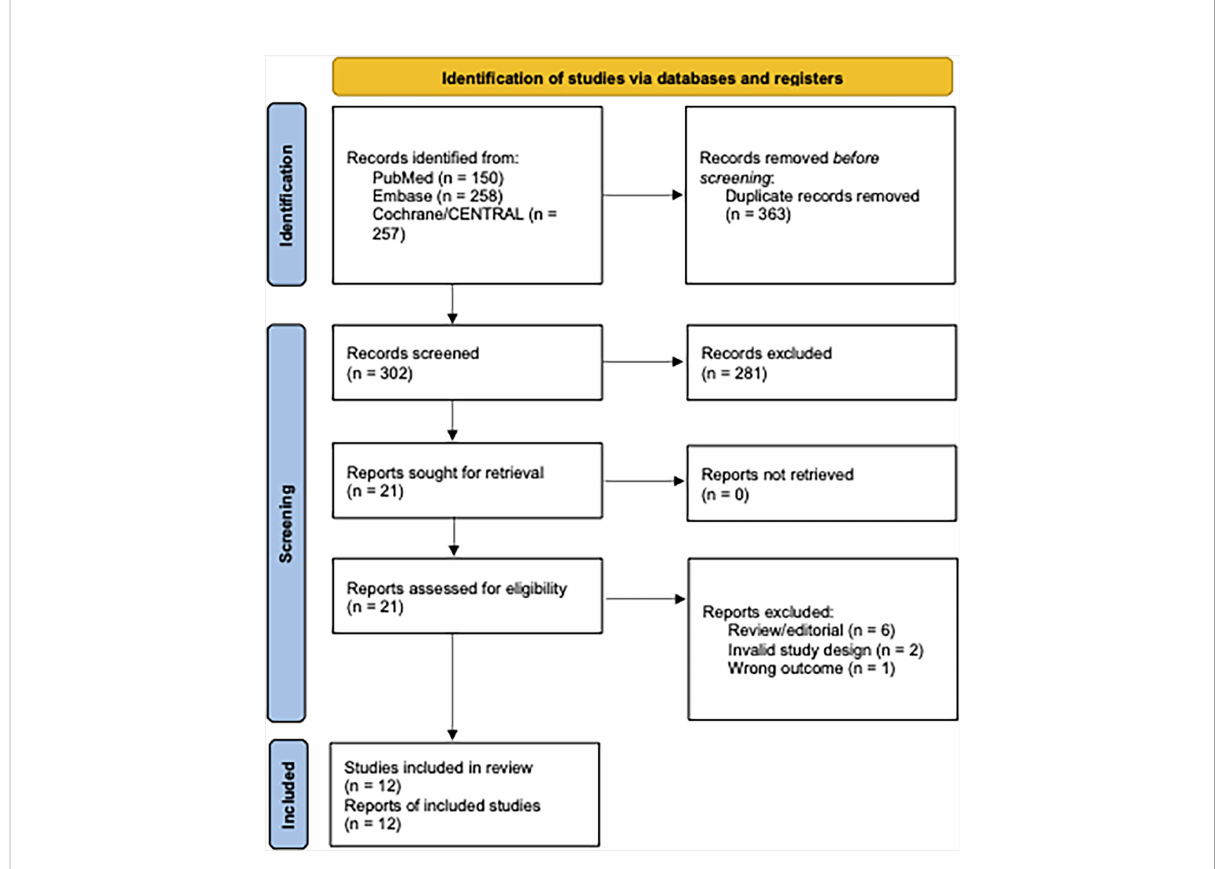
FIGURE 1 Flow diagram of identi fi ed and selected studies. Diagram adapted from